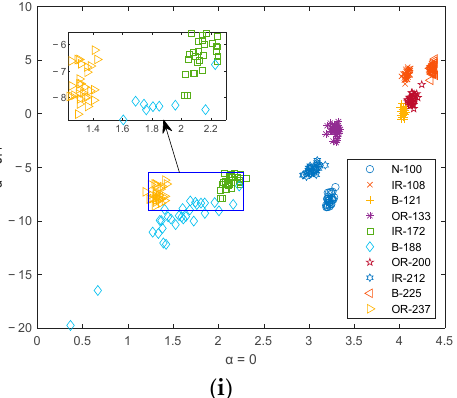
Figure 8. Double feature distribution of the nine highest classification accuracies: ( a ) FrPE, α = − 0.3&0; ( b ) FrWPE, α = − 0.3&0.3; ( c ) FrDE, α = 0.1&0.3; ( d ) FrFDE, α = − 0.3& − 0.1; ( e ) PSO- FrSlEn, α = − 0.3&0.2; ( f ) PSO-FrSlEn, α = − 0.2&0.2; ( g ) PSO-FrSlEn, α = − 0.1&0.1; ( h ) PSO-FrSlEn, α = − 0.1&0.2; ( i ) PSO-FrSlEn, α = 0&0.1.